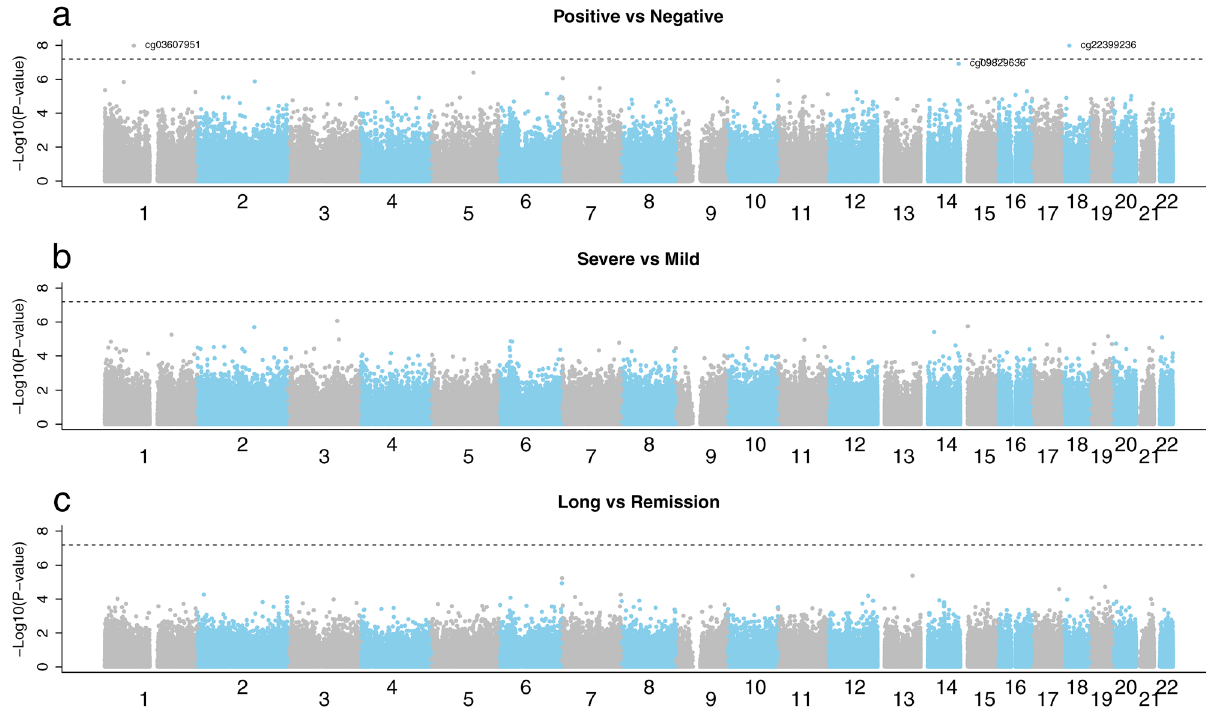
Figure 3. Manhattan plots for the EWASs. The Manhattan plots display the association statistics at each of the 776,892 autosomal probes between ( a ) COVID-19 positive (n = 109) and COVID-19 negative (n = 73), ( b ) severe COVID-19 (n = 61) and mild COVID-19 (n = 48), and ( c ) long-COVID (n = 41) and remission (n = 63). The dotted horizontal line is the Bonferroni threshold (0.05/776,892 CpG sites), and the labeled dots are the significant CpGs at FDR < 0.05.